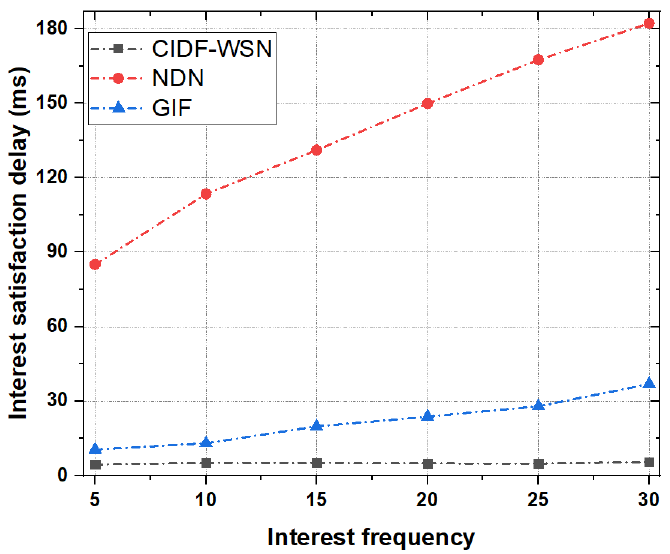
Figure 8. Interest satisfaction delay as a function of